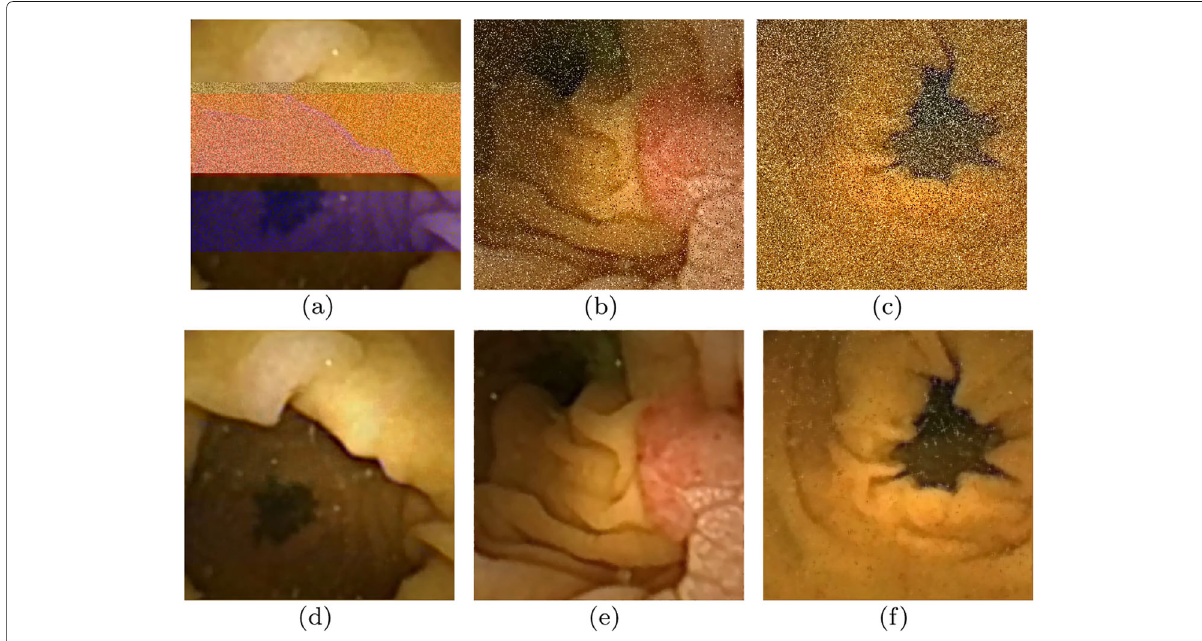
Fig. 9 Selection of noisy images and their inpainted version used during the subjective experiments. a Error blocks. b Dense noise. c Very dense noise. d Temporal inpainting with homography H and Poisson editing. e Inpainting with 5 × 5 MF. f Inpainting with 6 × 6